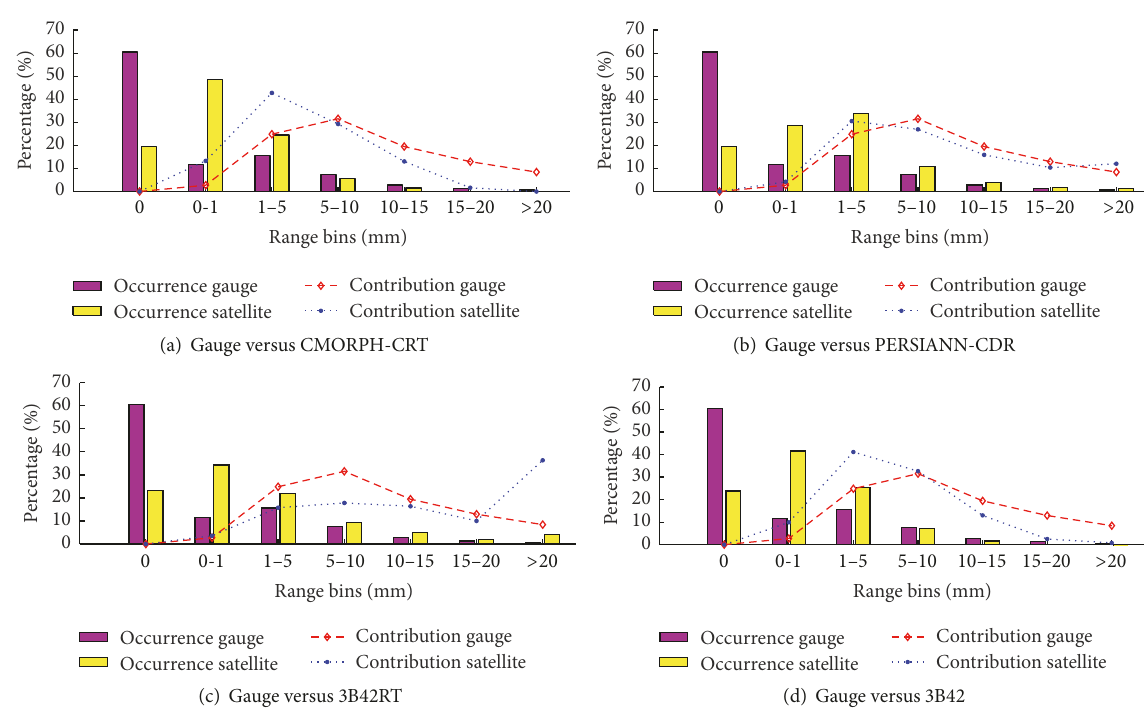
Figure 7: The intensity distribution of daily precipitation in different precipitation classes and their relative contributions to the total precipitation during the period 2008 to